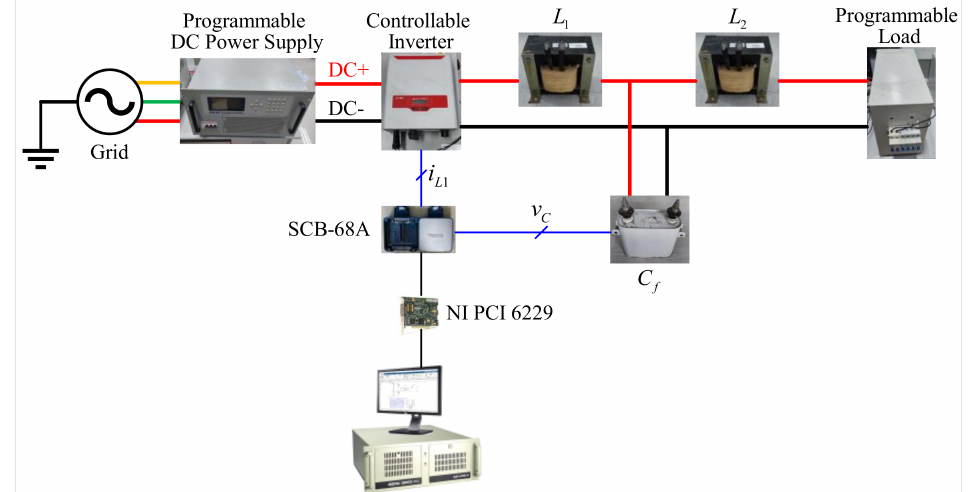
Figure 27. Configuration of the experimental setup.